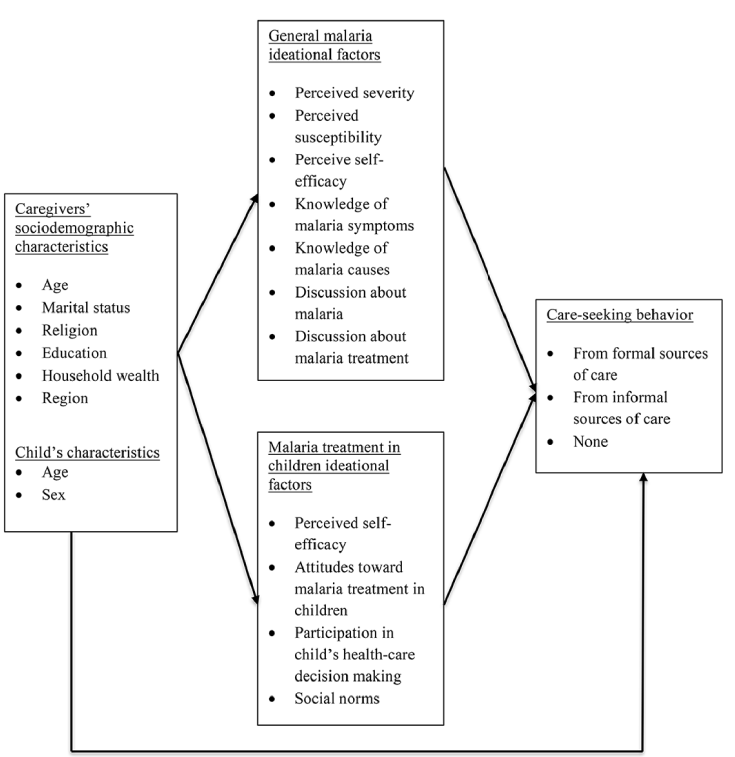
Fig 1. Malaria-related ideational factors and care-seeking behavior for fever among children under five.